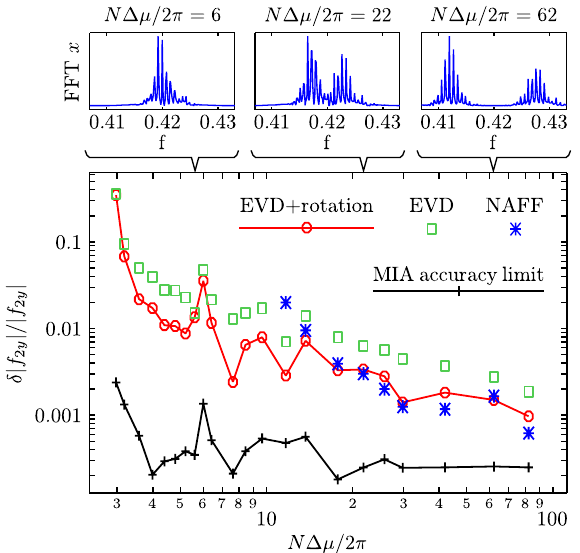
FIG. 8. Accuracy of betatron function determination versus tune separation. The turn-by-turn data was obtained via many- particle tracking simulations with different skew-quadrupole settings. Notations are the same as in the Table I. ‘‘ EVD þ rotation’’ means that the EVD algorithm (see Appendix) instead of plain SVD was used as initial step in our rotational mode untangling method. This approach provides the best accuracy.